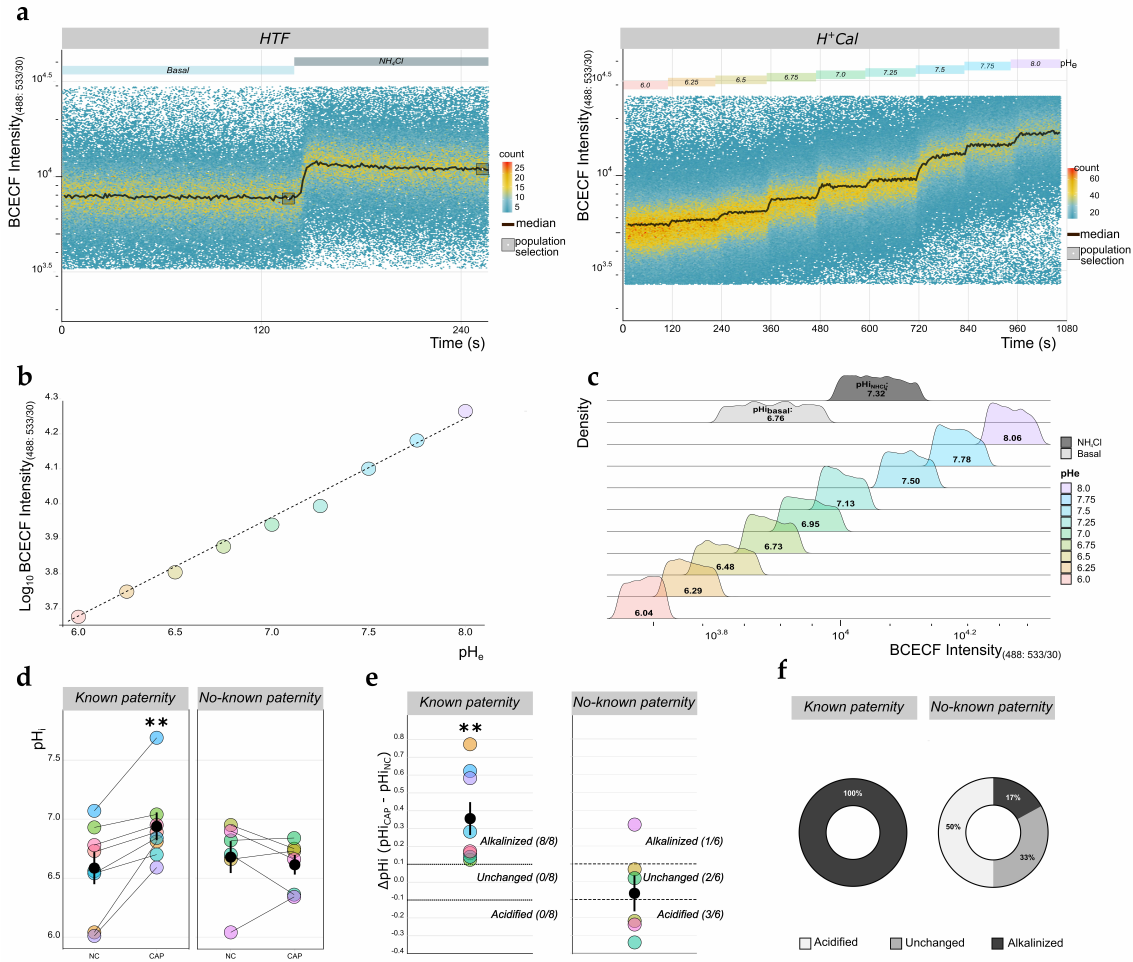
Figure 5. Measurement of intracellular pH (pH i ) absolute values in human sperm. ( a ) Representative time-lapse flow cytometry (TLFC) 2 (cid:48) ,7 (cid:48) -bis-(2-carboxyethyl)-5-(and-6)-carboxyfluorescein acetoxymethyl ester (BCECF-AM, abbreviated to BCECF) fluorescence density plots of a sperm sample from a known paternity donor incubated under non-capacitating (NC) conditions in either human tubal fluid (HTF) (left panel) or calibration (H + Cal) (right panel) medium. Colored boxes above the plots indicate the nature and duration of the employed stimuli. The dark solid lines indicate the median fluorescence values. Gray boxes enclose the cell subpopulations selected to perform further calculations. ( b ) Median log 10 -transformed BCECF fluorescence values of the selected subpopulations indicated in ( a ) (right panel) plotted against pH e . The dashed line indicates the linear fit model ( y = − 0.29x − 1.93; R 2 = 0.99; p = 7.5 × 10 − 9 ). ( c ). Density histograms of BCECF fluorescence values from the selected cell subpopulations indicated in ( a ) (right panel). For comparison, each colored histogram corresponds to each of the estimated pH i values (using the Henderson-Hasselbalch equation); the interpolated basal (light gray) and NH 4 Cl-alkalinized (dark gray) pH values (indicated inside histograms) were 6.76 and 7.32, respectively. ( d ) Plots of estimated pH i values for individual sperm samples (shown color-coded) incubated under either NC or capacitating (CAP) conditions, from either known ( n = 8) or no-known ( n = 6) paternity donors. Black dots and solid lines indicate mean ± SEM, respectively; ** p < 0.01 against NC conditions according to a Wilcoxon matched-pairs signed-rank test. ( e ) Plots of the capacitation-induced pH i change ( ∆ pH i = pH iCAP − pH iNC ) for samples in ( d ). Samples with a ∆ pH i greater, lower, or equal to ± 0.1 pH i units were classified (dotted lines) as alkalinized, acidified, or unchanged, respectively; numbers in parentheses indicate the number of samples in each category out of the total. Black dots and solid lines indicate mean ± SEM, respectively; ** p < 0.01 according to a one-sample t -test comparison against a theoretical mean of ∆ pH i = 0. ( f ) Donut charts depicting the distribution of the results shown in ( e ).